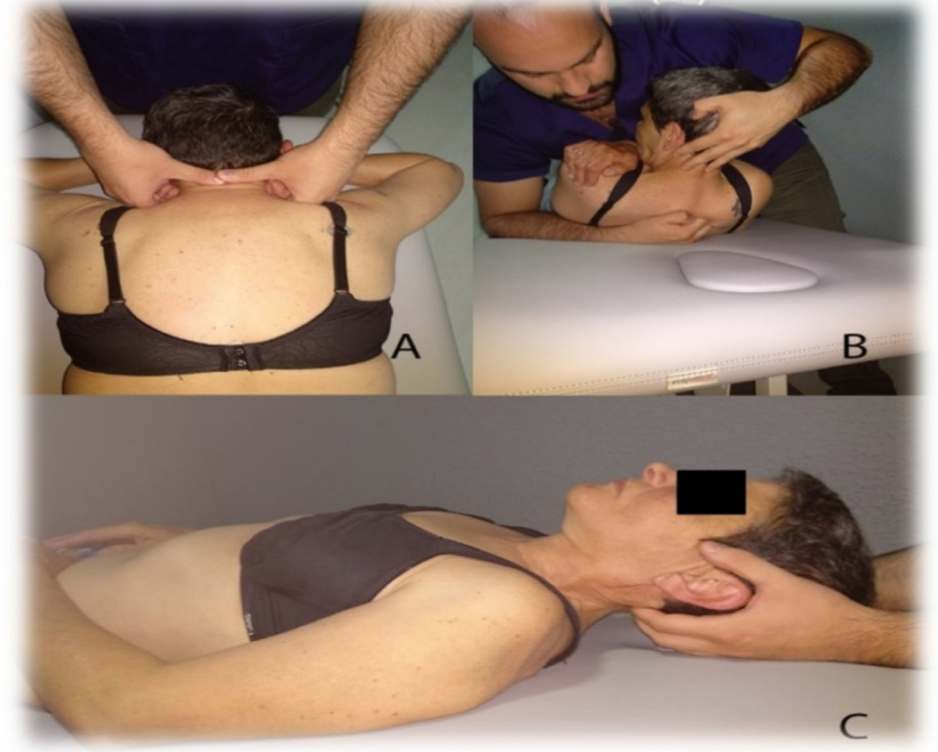
Figure 1. Manual Therapy Protocol. ( A ) Cervical Articular Mobilization, ( B ) High Thoracic Manipu- lation on T4, ( C ) Suboccipital Muscle